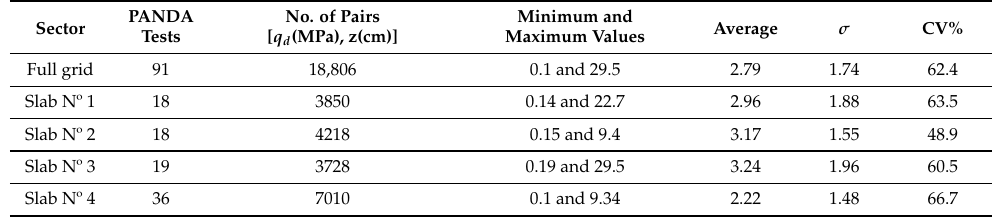
Table 7. Statistical summary of in-situ q d measurements for the full survey grid and test slabs.